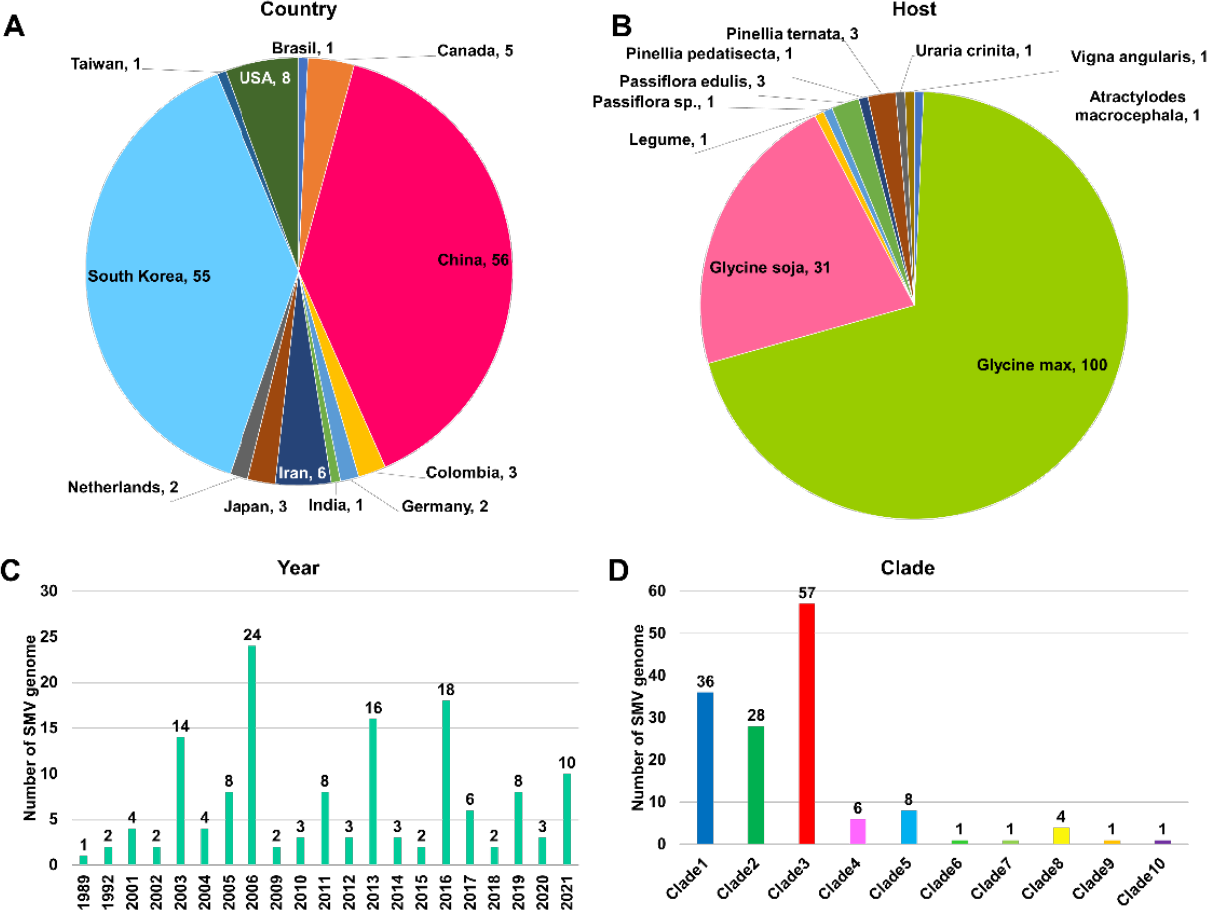
Figure 1. Information for 143 SMV genomes and the 10 identified clades. Pie charts display infor- mation for each country where SMV genomes were obtained ( A ) and the host plants from which SMV genomes were obtained ( B ). The bar graph shows the number of SMV genomes based on the year of identification ( C ). Information for the 10 clades of 143 SMV genomes that were identified using phylogenetic analysis ( D ).